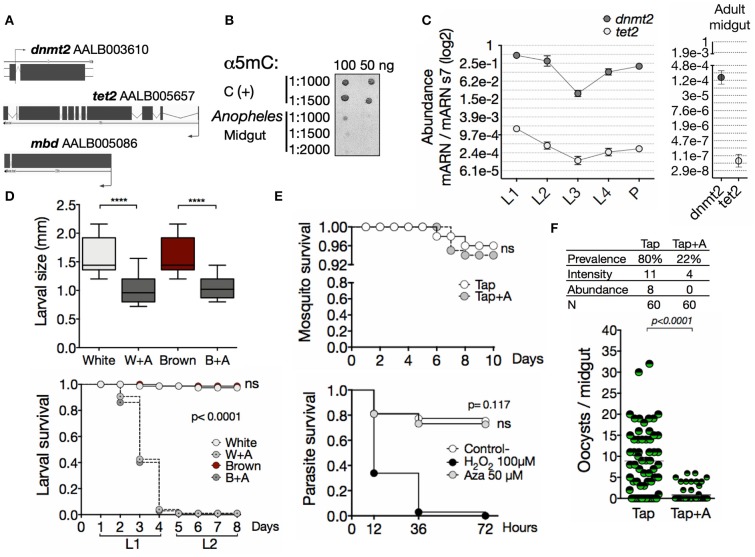
A functional methylation system is involved in the development of Anopheles albimanus and their infection by Plasmodium. (A)
In silico identification of the basic methylation system. (B) Immuno-detection of 5mC in midgut gDNA. C (+), hypermethylated control. 1:1,000, 1:1,500, and 1:2,000 denote α5mC dilutions. (C) Expression of dnmt2 and tet2 during development and adulthood, determined by qPCR. Mean ± standard error of the mean (SEM) of two independent experiments. (D) Larval size 4 days post hatching (two independent experiments with 30 larvae per group) and survival (two independent experiments performed in triplicates) after treatment with azacytidine. P values were calculated by Kruskal-Wallis followed by Dunns test and Mantel-Cox test, respectively: ****P < 0.0001. (E) Mosquito survival of the parental (Tap) strain and in vitro parasite survival following 72 h of 50 μM azacytidine treatment. For parasites, PBS was used as negative control and H2O2 as positive control. Mean ± SEM of three independent experiments analyzed by Mantel-Cox test. (F) Parasite infection following azacytidine treatment of the Tap strain. Two independent experiments with 30 mosquitoes for each experiment and analyzed by Mann-Whitney test. Infection parameters were calculated as follows: prevalence, percentage of infected mosquitoes; intensity, average number of oocysts per infected mosquito; abundance, average number of oocysts per total mosquitoes.